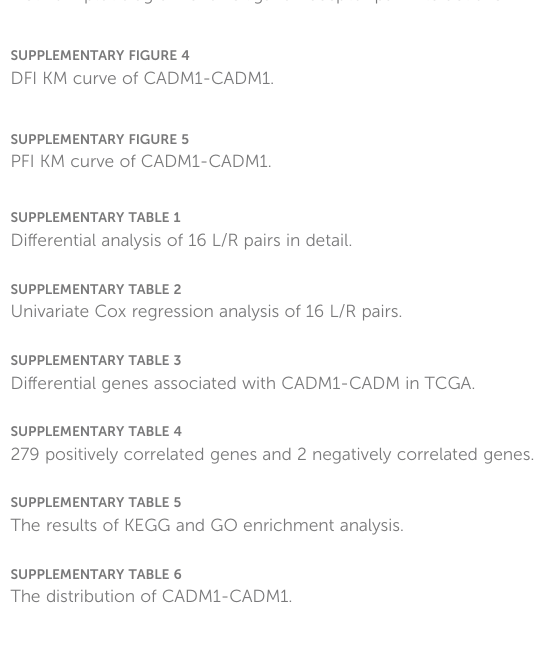
SUPPLEMENTARY FIGURE 2 t-SNE projection showing the expression of marker genes in 9 cell clusters. SUPPLEMENTARY FIGURE 3 Network plot diagram shows ligand-receptor pair interactions.